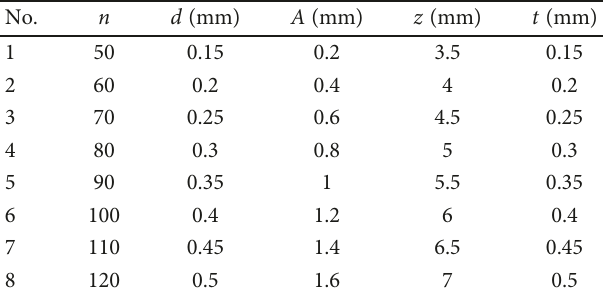
Table 9: The analysis results of the p value for T , σ , τ , and m . Factor p value for T p value for σ p value for τ p value for